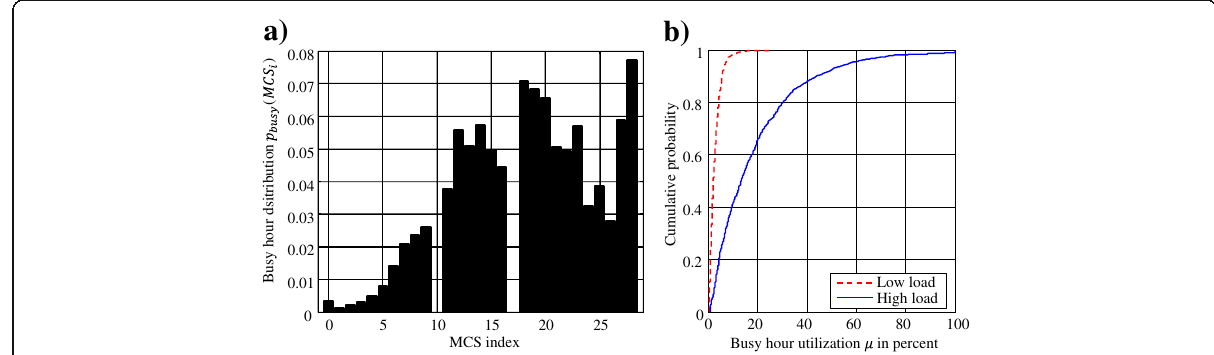
Fig. 4 Busy hour distributions. a MCS index distribution. b CDF of